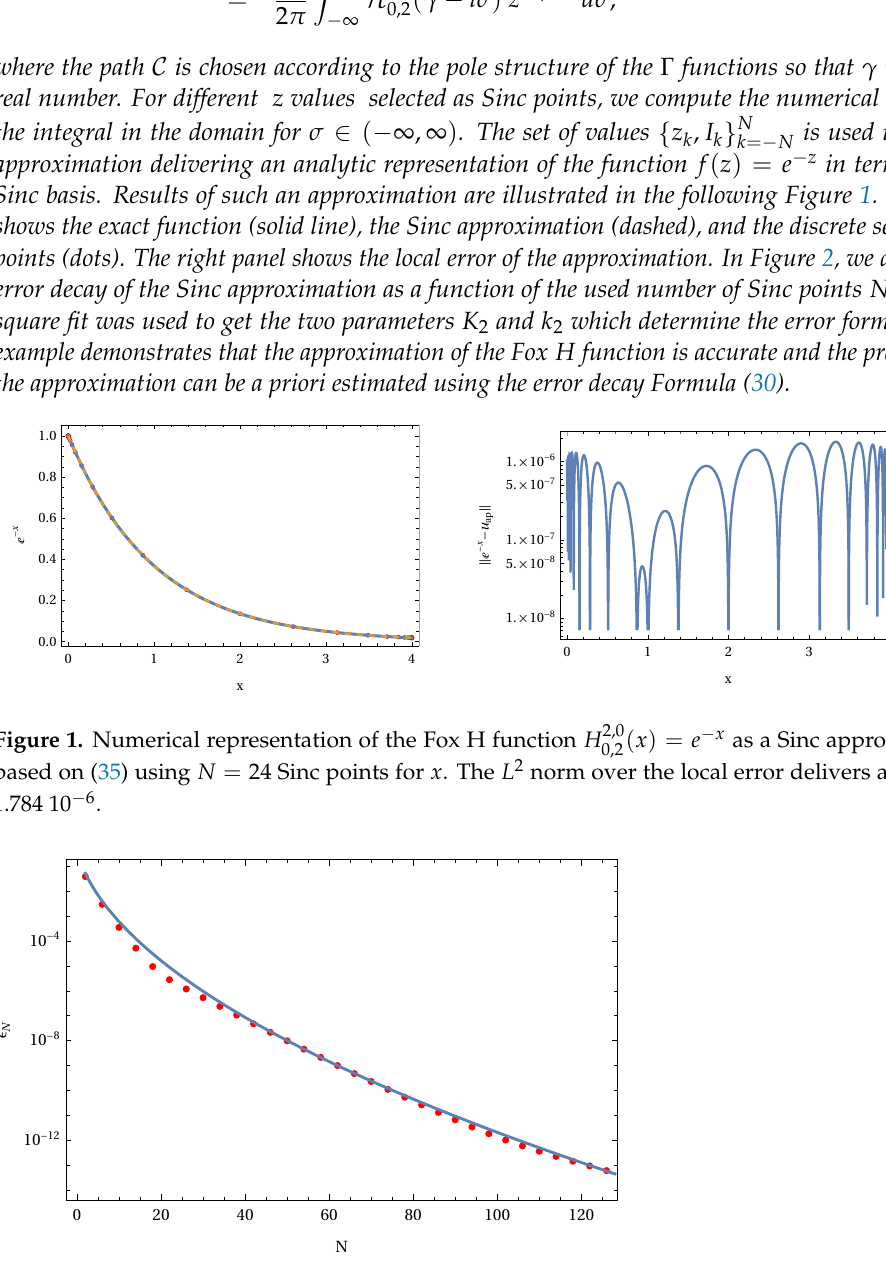
Figure 2. Error decay (cid:101) N = (cid:107) u − u ex (cid:107) ∼ K 2 N 1/2 exp The two parameters K 2 and k 2 are the result of a least square